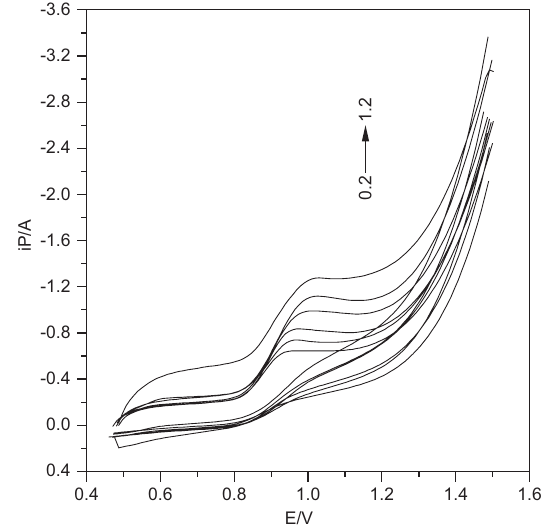
Figure 6 Infl uence of different HPM α FP amount on cyclic volta- mmograms by every 20 mV and HPM α FP/GCE at scan rates from 0.01 to 0.25 V/s.